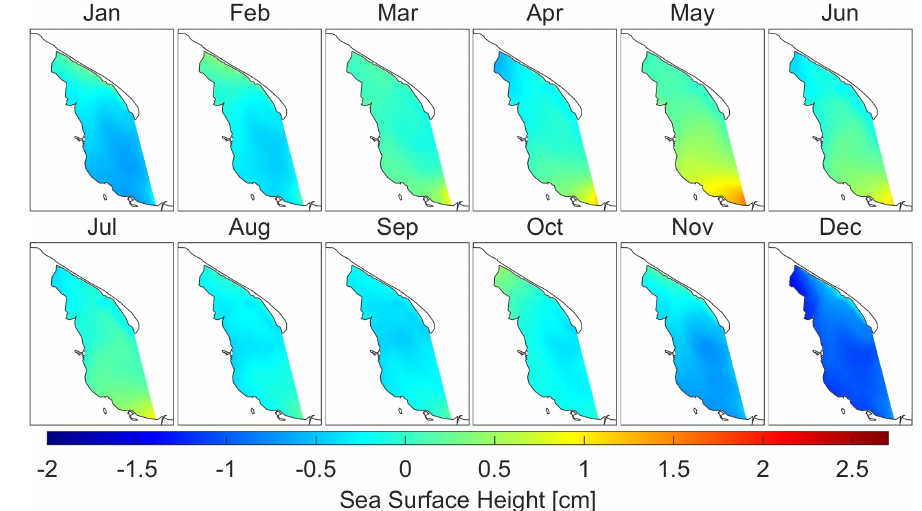
Figure 12. Monthly means of sea surface height.